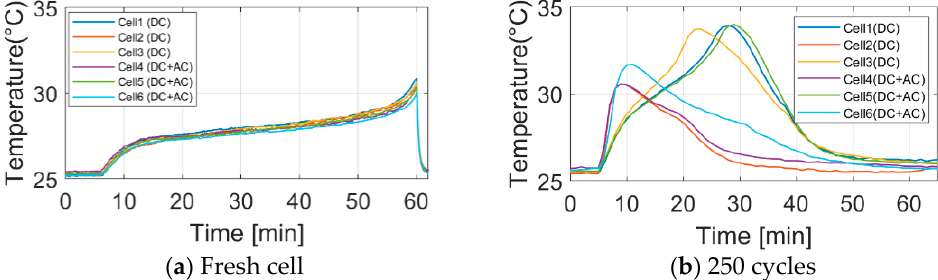
Figure 7. The difference in temperature during discharge operation for all cells at fresh condition ( a ) and after 250 cycles ( b ).